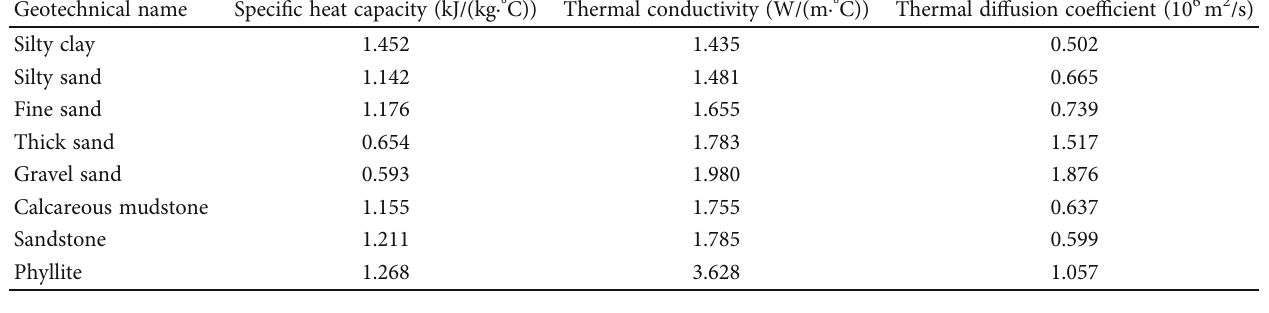
Table 1: Comparison of di ff erent geotechnical thermal properties in the survey area.